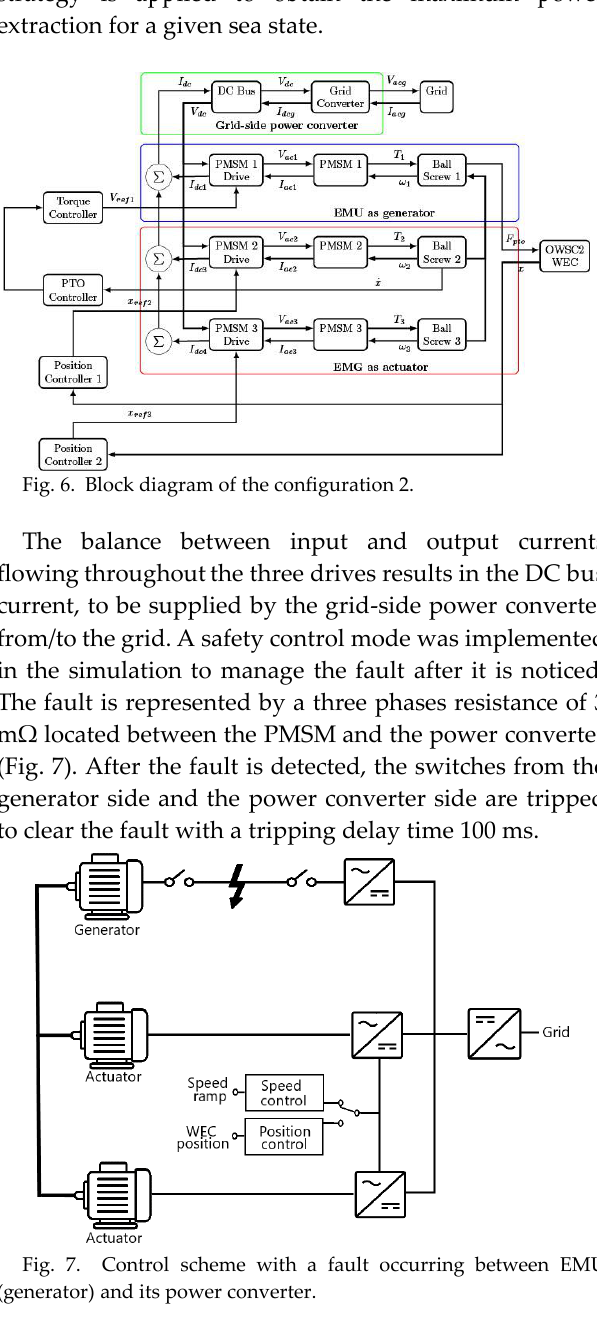
Fig. 5. HIL test rig Simulink model.